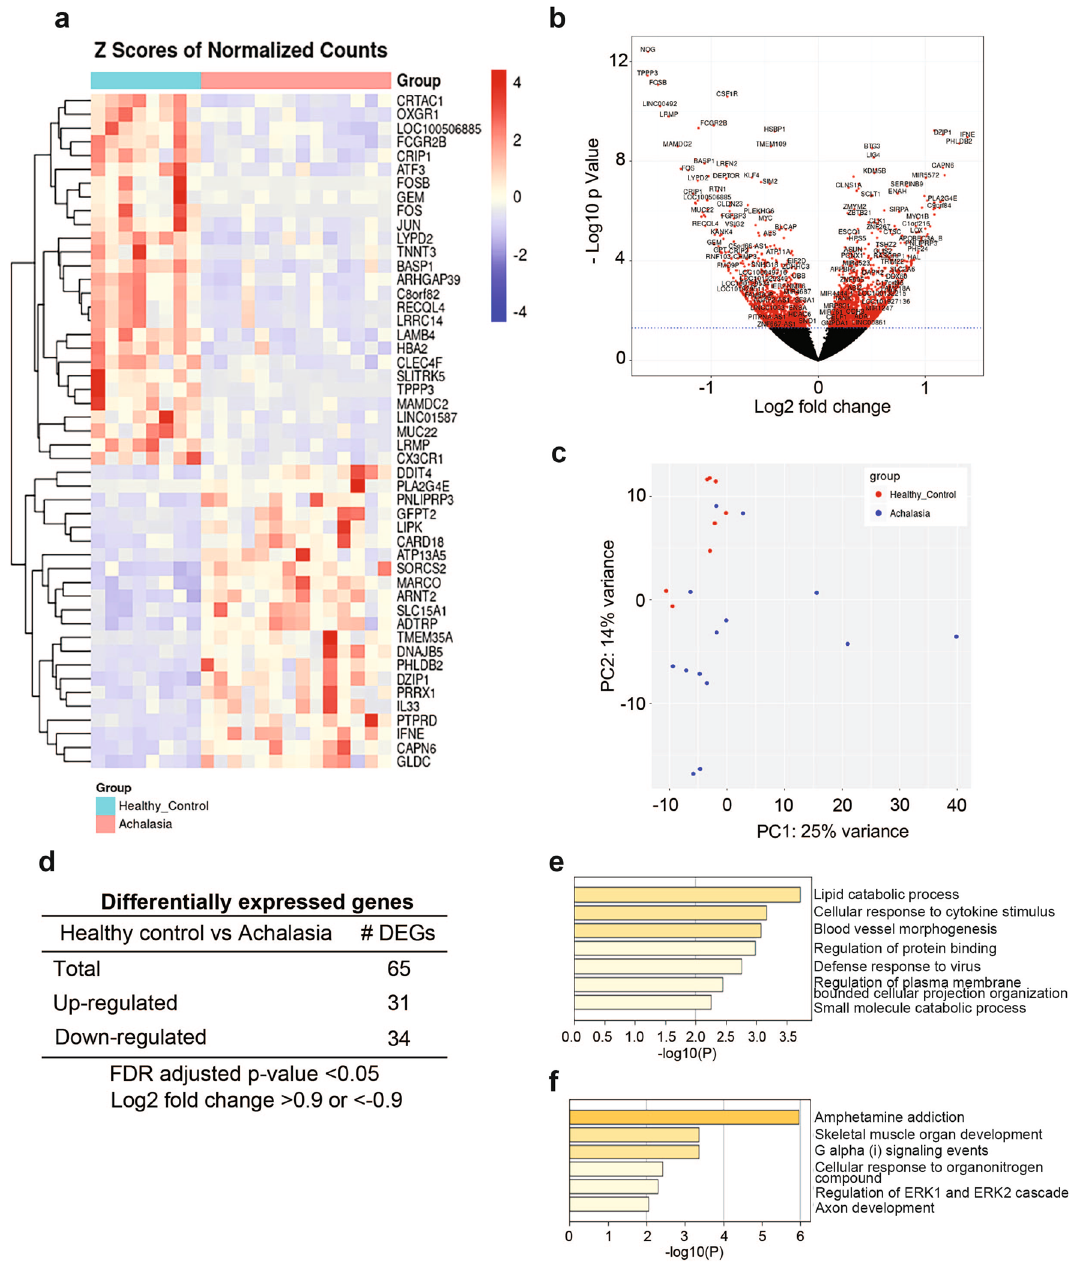
Figure 2. Differential gene expression analysis comparing changes in distal esophageal mucosa of achalasia. ( a ) Heat map of RNA sequencing (RNA-seq) expression data showing differentially expressed genes in achalasia. ( b ) Volcano plot showing the log2 fold change in gene expression in achalasia as well as the statistical significance. ( c ) Principal component analysis of RNA-seq gene expression profiles. red = healthy control, blue = achalasia. ( d ) The number of differentially expressed genes (DEGs) in achalasia based on a log2 fold change of 0.9 and FDR < 0.05. ( e ) A heatmap of the top up-regulated pathways is shown. ( f ) A heatmap of the top down-regulated pathways is (Fig. 6a,c). A significant increase in the recruitment of intraepithelial leukocytes was also observed in the proxi- mal esophageal mucosa of achalasia patients (Fig. 6e,f) compared to controls (Fig. 6d,f). Distinct changes in gene expression and differentially regulated pathways are observed in the proximal and distal esophagus of type I versus type II achalasia patients. Given that type I acha- lasia is usually a later phase of disease progression, we next determined differential gene expression between type I or type II achalasia and healthy controls, in both proximal and distal esophagus. As showed in Fig. 7a, we identified 501 DEGs (240 up-regulated and 261 down-regulated) in the distal esophagus of type I achalasia